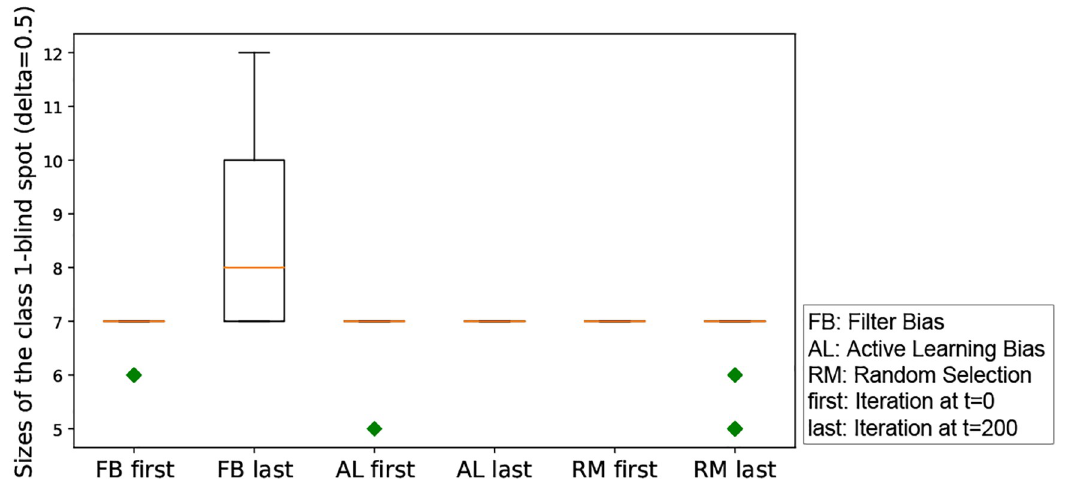
Fig 12. The box-plots showing the size of the class-1 blind spot in the first and last iterations of the iterated learning for three iterated algorithmic biases with human action probability ratio 10:1. Filter bias significantly decreases the number of points predicted to be in class y = 1. On the other hand, random selection significantly increases the number of points predicted to be in class y = 1. Active learning has no such significant effect.